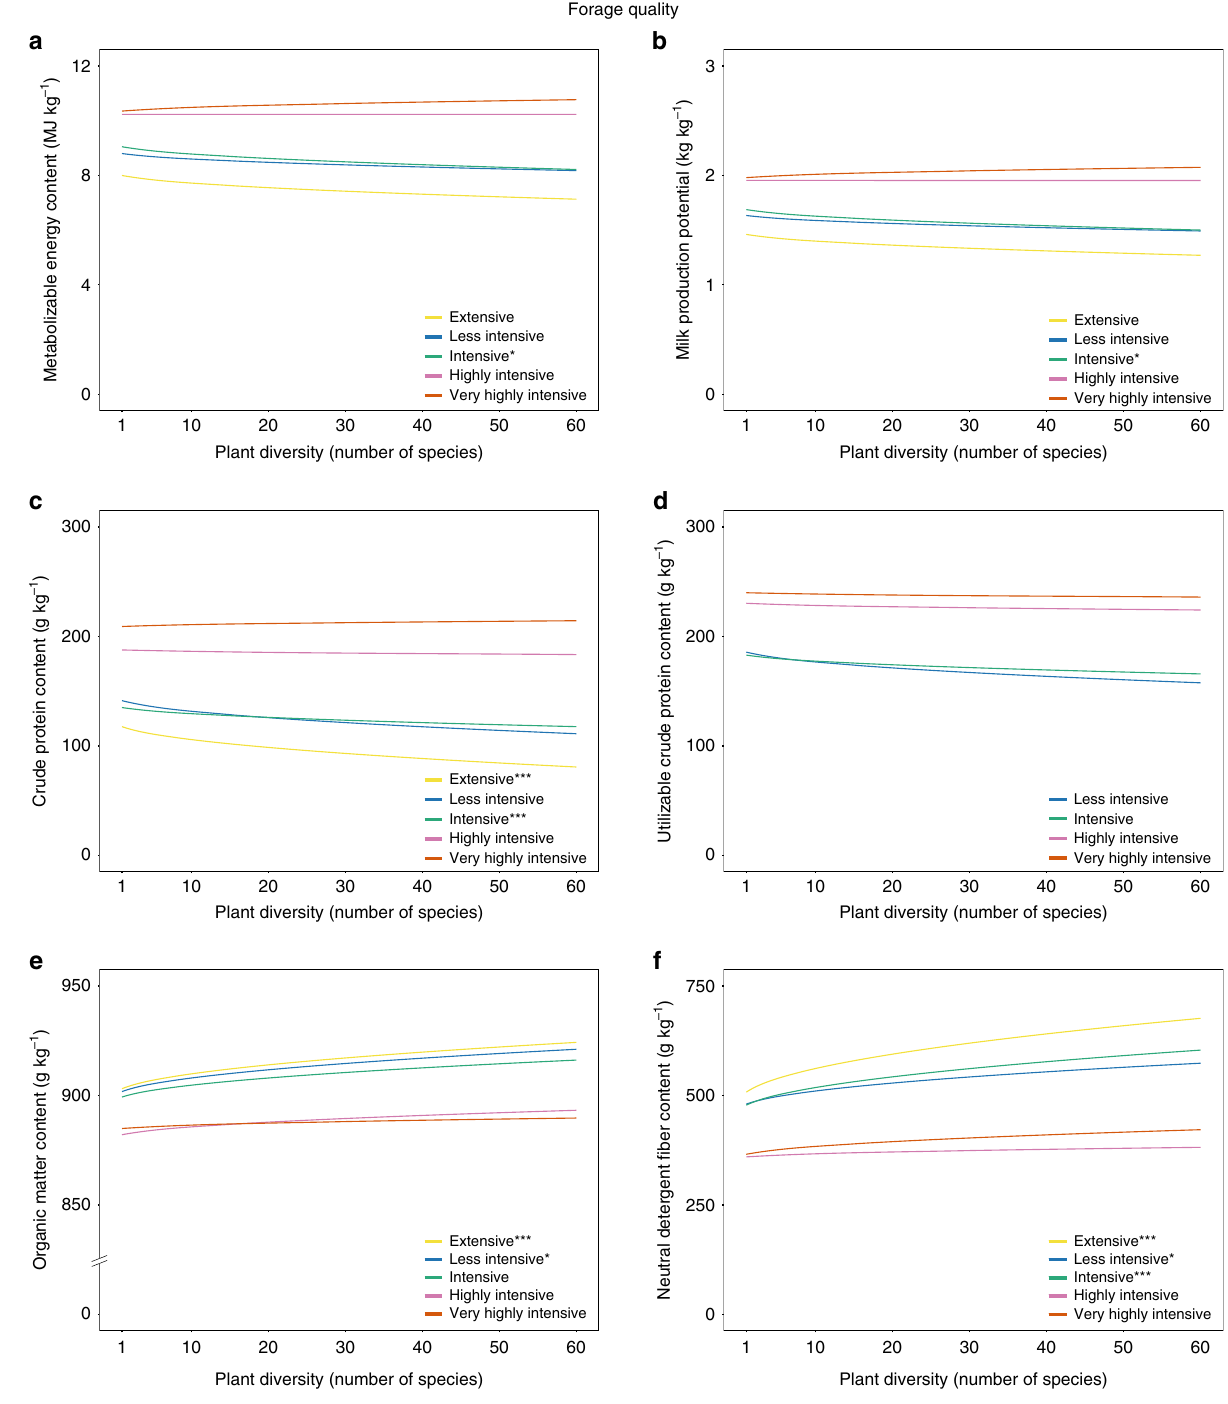
Fig. 5 Predicted values of annual average forage quality. Predicted annual average forage quality as a function of plant diversity levels and management intensity include metabolizable energy content (MJkg − 1 ) a , milk production potential (kgkg − 1 ) b , crude protein content (gkg − 1 ) c , utilizable crude protein content (gkg − 1 ) d , organic matter content (gkg − 1 ) e , and neutral detergent fi ber content (gkg − 1 ;) f . *, **, *** denote signi fi cance at the 5%, 1%, and 0.1% level of the plant diversity effect per management intensity, respectively (corrected for multiple comparisons). The signi fi cance levels are based on a mixed effect model, see Eq. (4). The corresponding coef fi cients for the plant diversity effect per management intensity can be found in Supplementary Tables 3 – 5. Utilizable crude protein content was only measured for the fi rst cut of the year. Note that the y -axis break in the fi gure of organic matter content. Source data are provided as a Source Data fi